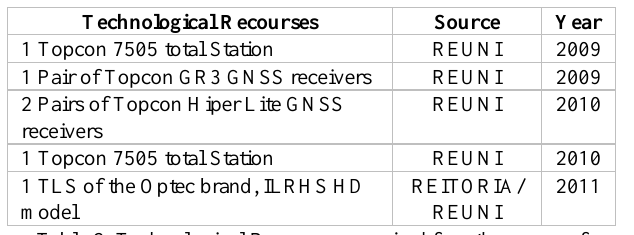
Table 2. Technological Resources acquired for other areas of Cartographic Engineering.